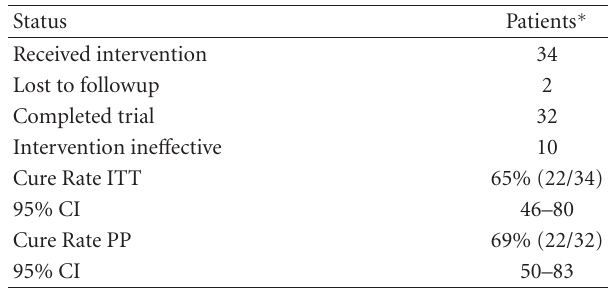
Table 1: Intervention status of patients enrolled in the study. Status Patients ∗